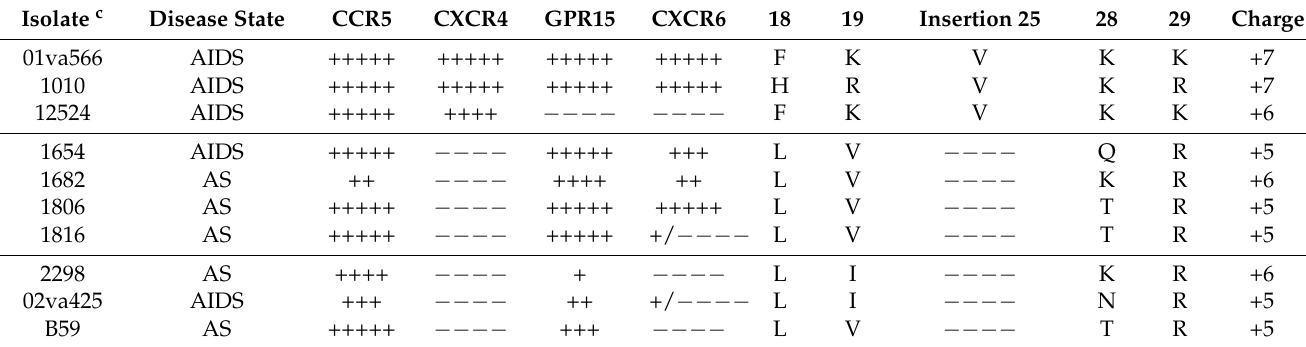
Table 1. Co-receptor use a and outer Env V3 loop amino acid motifs b of HIV-2 isolates. Isolate c Disease State